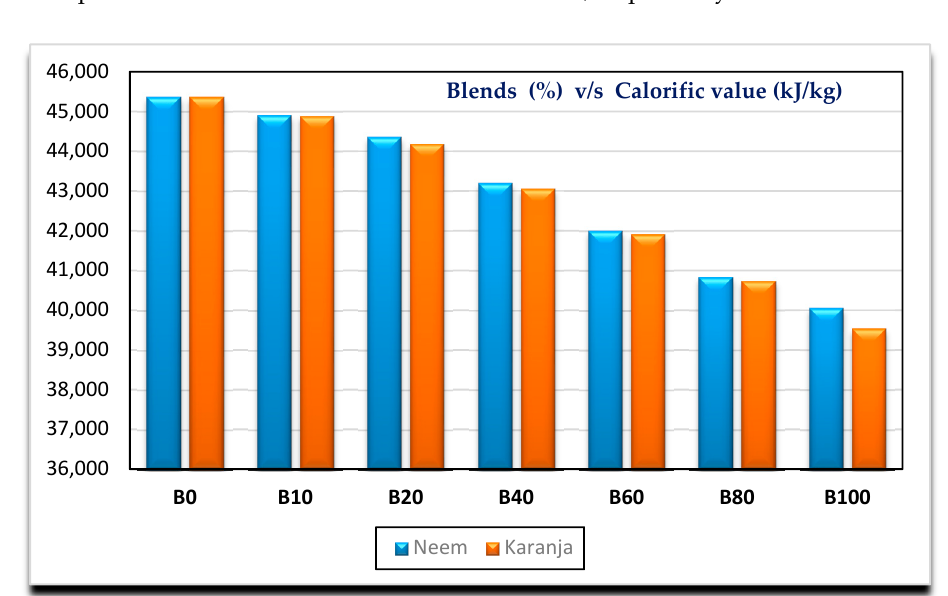
Figure 2. Variation of calorific value with biodiesel-diesel blends.